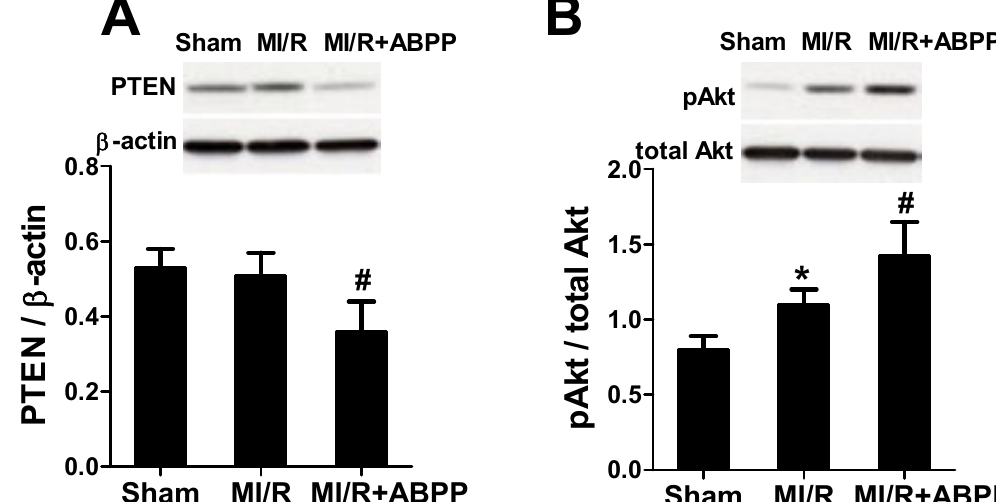
Figure 5. Achyranthes bidentata polypeptides (ABPP) preconditioning inhibited PTEN expression and increased Akt phosphorylation in rats subjected to myocardial ischemia/reperfusion. ( A ) PTEN expression; ( B ) Akt expression and phosphorylation. Top images: representative blots; MI/R, myocardial ischemia/reperfusion (30 min/4 h); Sham, sham-operated; ABPP, Achyranthes bidentata polypeptides. Values presented